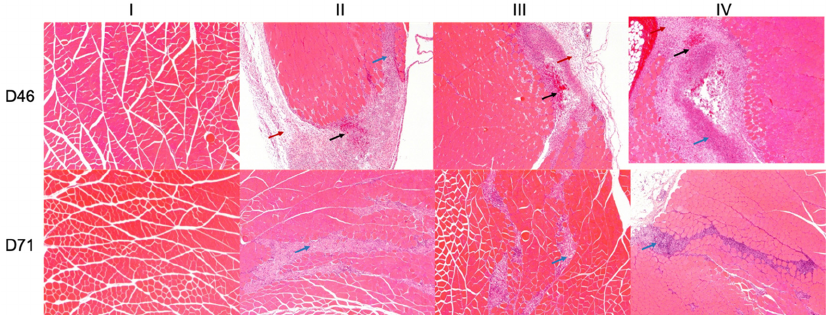
Figure 4. Histopathological sections at the site of injection (muscle) on first and second euthanasia. I-control, II-adjuvant, III-Omicron COVID-19 (low dose), IV-omicron COVID-19 (high dose). The sections were stained by hematoxylin-eosin (HE). I-normal muscle, II/III/IV-D46-muscle with inter- stitial granulomatous inflammation, acute inflammation and hemorrhage, II/III/IV-D71-muscle with interstitial granulomatous inflammation. Black arrow represents hemorrhage; red arrow represents acute inflammation; blue arrow represents granulomatous inflammation.